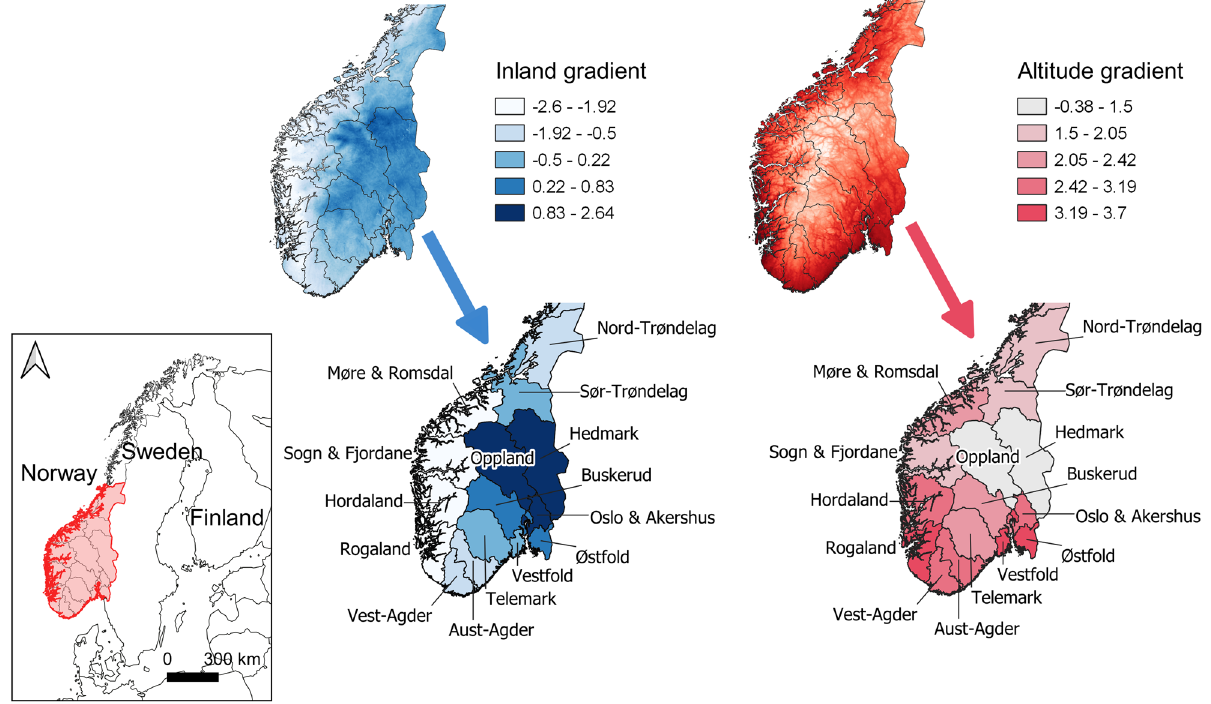
Figure 2. The classification of counties in South Norway by Inland and Altitude gradients. The upper maps depict the gradients as continuous data, highlighting the within county variation. The lower maps show the means for each county based on values from arable land parcels. Increasing values of the Inland gradient are associated with distance from coast and cooler winter temperatures. Increasing values of the Altitude gradient are linked with lower latitudes, altitudes and warmer summer temperatures. Inset map shows the location of South Norway (red outline) in relation to Scandinavia. Maps created with QGIS v3.18.1 (www. qgis. org) and gradient data from 20 .